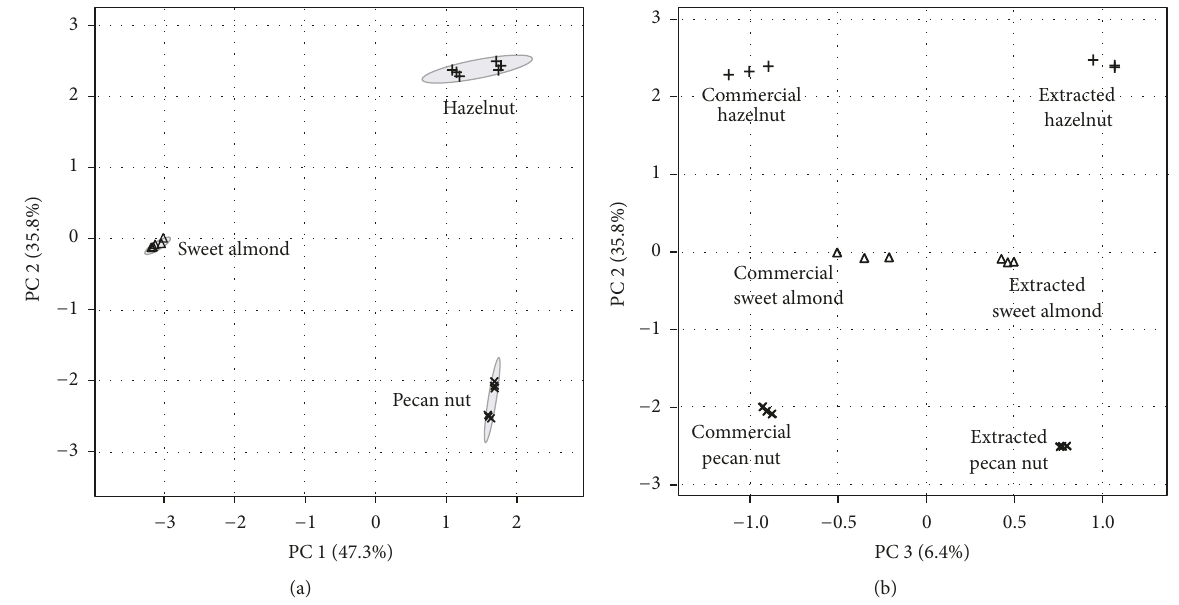
Figure 1: Principal component analysis score plot for all analyzed samples. PC1 × PC2 (a); PC2 × PC3 (b).